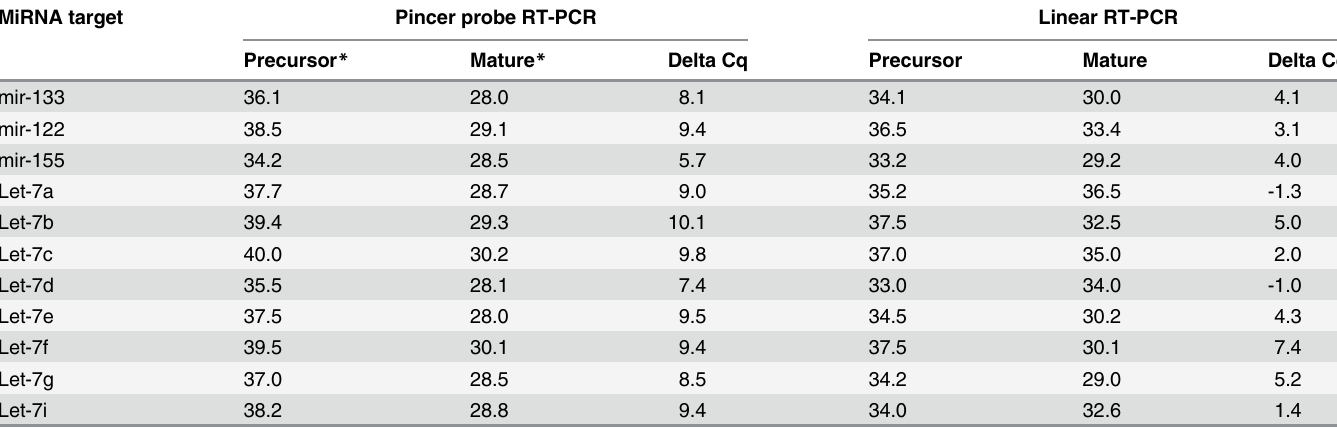
Table 2. Discrimination between the mature and the precursor miRNAs using pincer probe or linear real-time RT-PCR. MiRNA